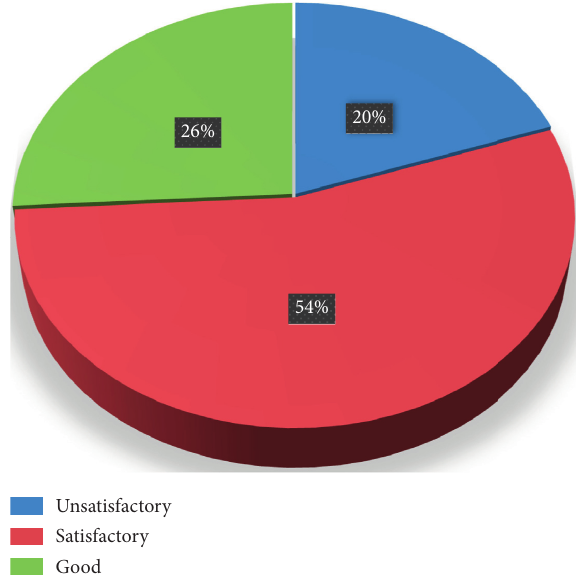
Figure 4: Categories of nurses’ practice regarding physical restraint ( n �